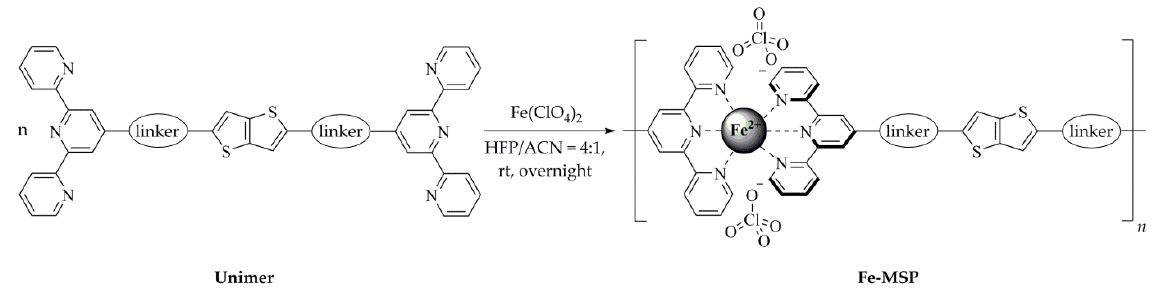
Scheme 3. Self-assembly of Fe 2+ -MSPs (metallo-supramolecular polymers) from unimers and Fe 2+